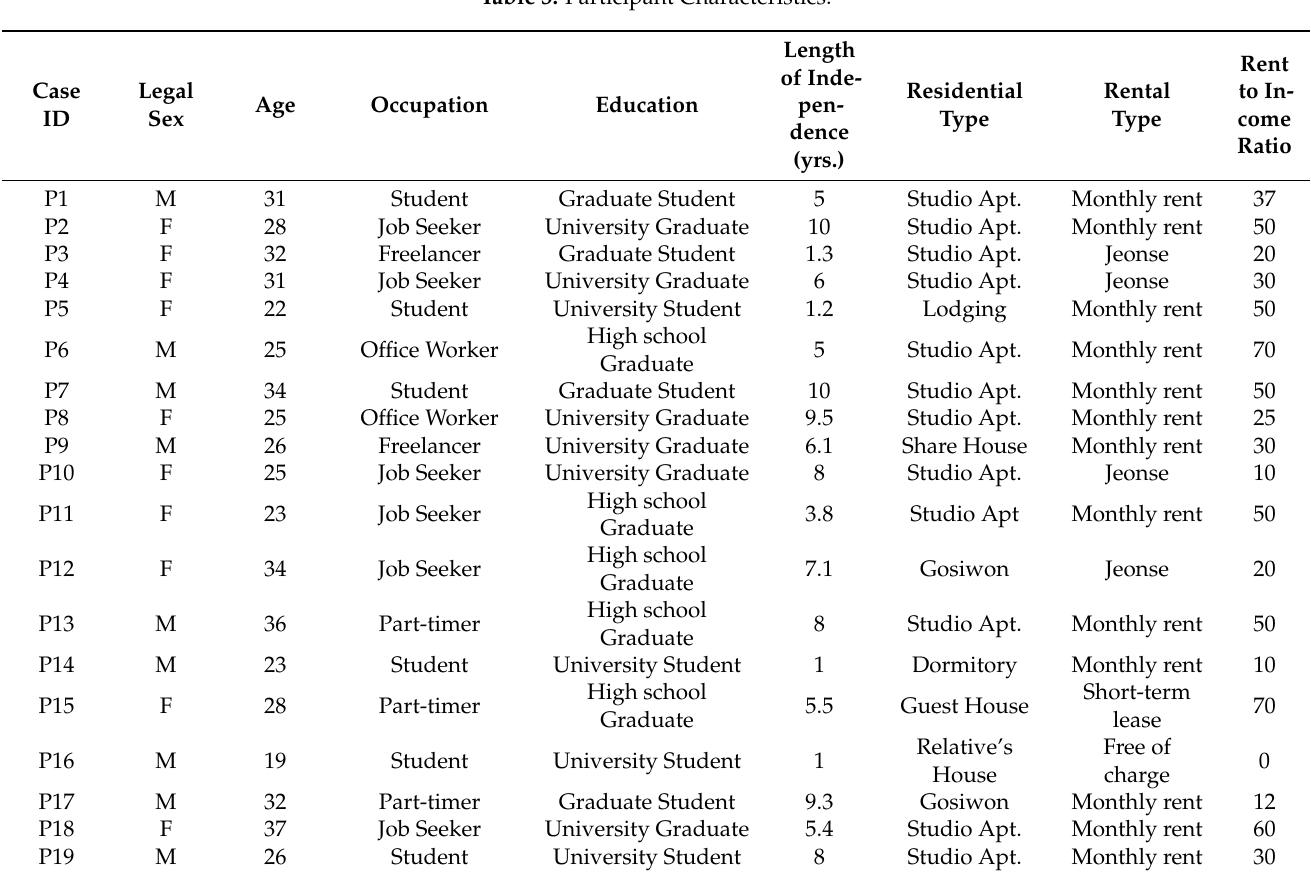
Table 3. Participant